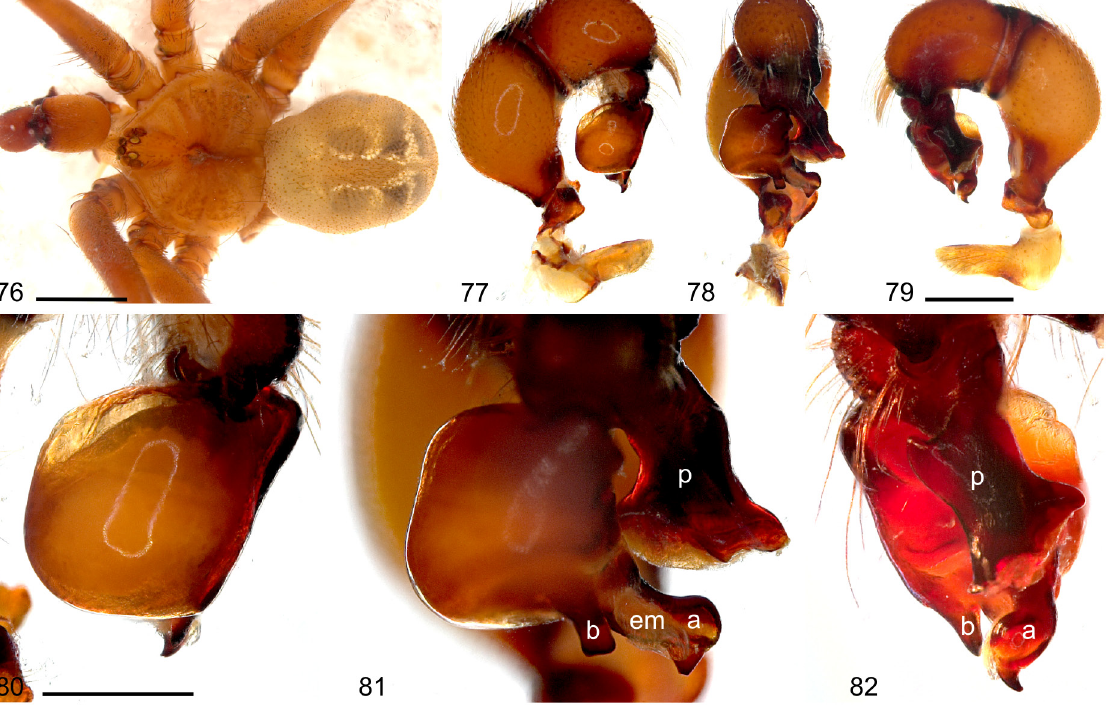
Figs 76–82. Artema kochi Kulczyński, 1901 (MNHN AR 10169 part, Yemen-Eritrea). 76 . Male habitus. 77–79 . Male left pedipalp: prolateral, dorsal, and retrolateral views. 80–82 . Male left bulb and procursus: prolateral, dorsal, and retrolateral views. Scale lines: 76 = 2 mm; 77–79 = 1 mm; 80–82 =